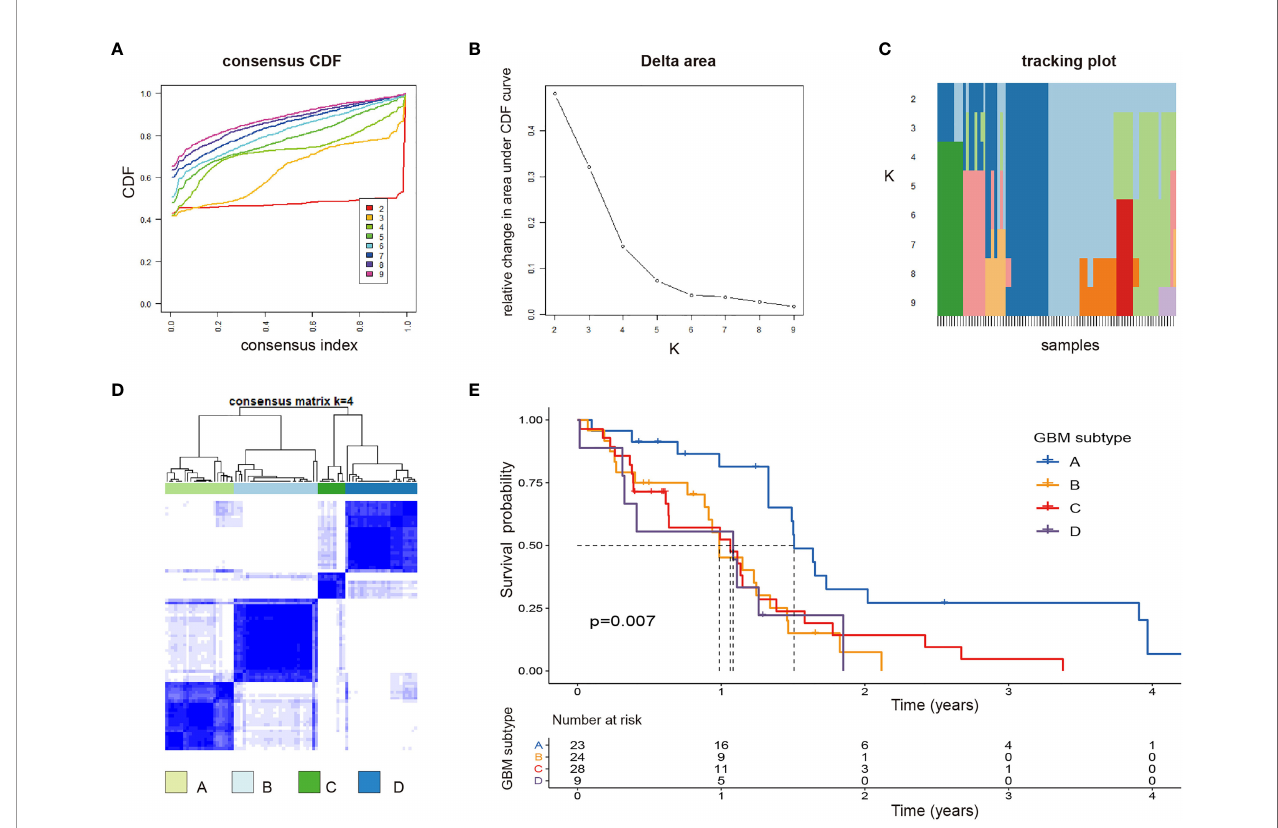
FIGURE 4 | Identi fi cation of potential GBM subtypes (A – C) Cumulative distribution function curve, delta area, and tracking plot of immune-related lncRNA in GBM. (D) Consensus clustering matrix for k = 4, which was the optimal cluster number in the TCGA training cohort. (E) Patients in the GBM subtype-A experienced a longer survival